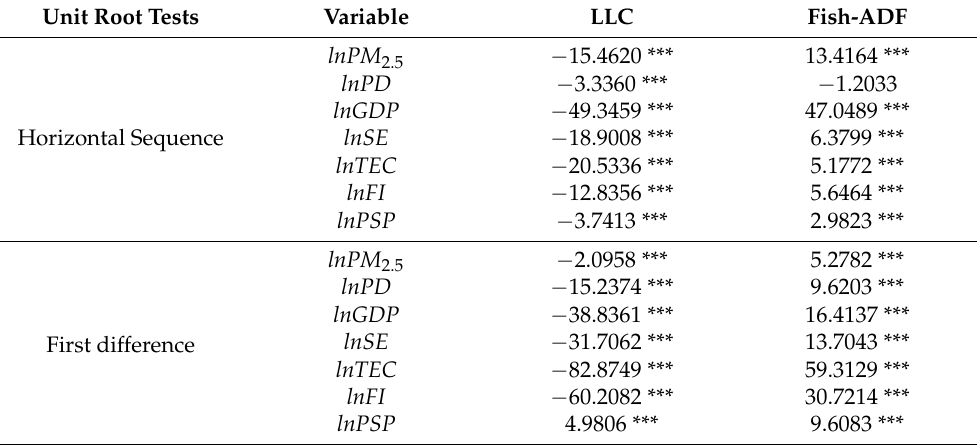
Table 2. Unit root tests of